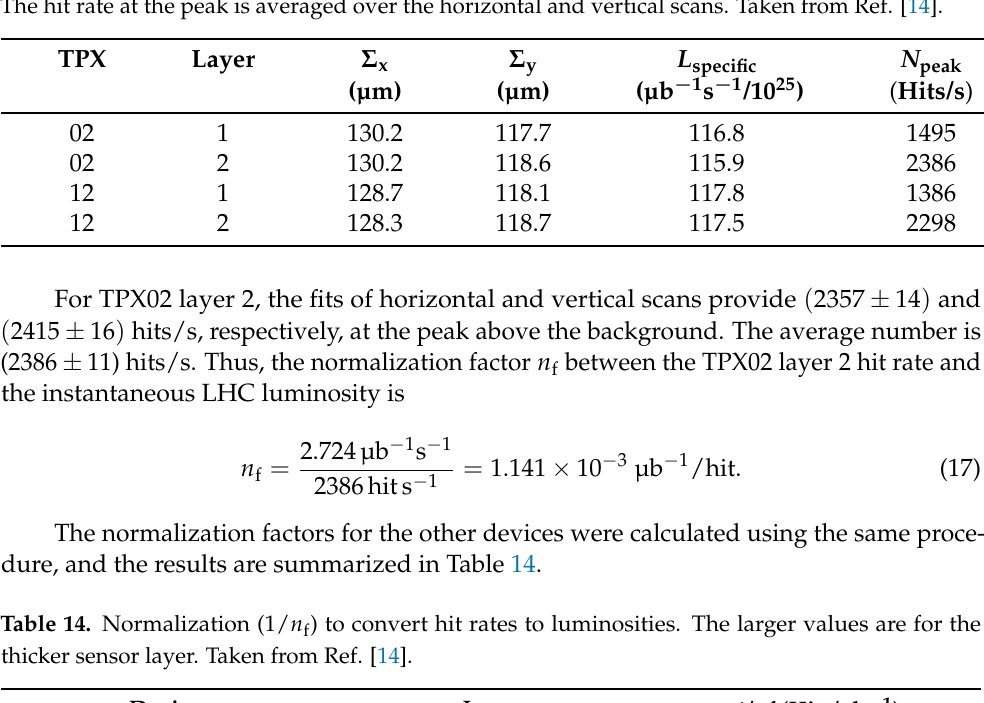
Table 13. vdM scan results for 2015 data. The scan was performed on 24–25 August (LHC fill 4266) and the first horizontal and vertical scans were used. The fit results for the first bunch-averaged horizontal. Σ x , and vertical, Σ y , convoluted beam sizes are given, as well as the specific luminosity. The hit rate at the peak is averaged over the horizontal and vertical scans. Taken from Ref. [14].